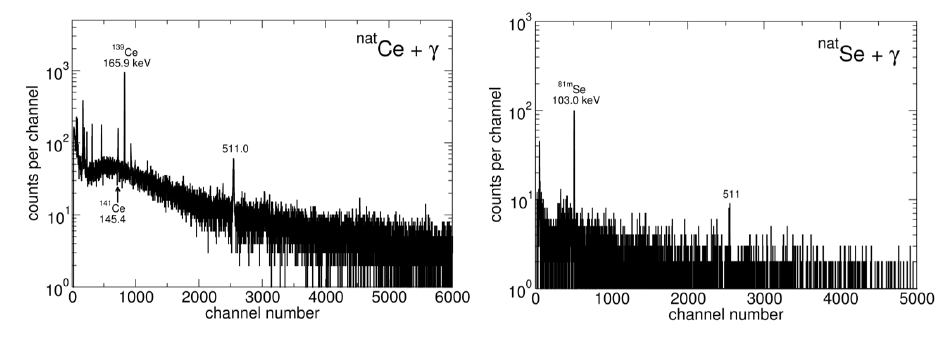
Figure 4: Gamma spectra accumulated with a shielded High-Purity Ge detector for targets of nat Ce (left) and nat Se (right) activated below the neutron production threshold resulting in only gammas and no neutrons. The 139 , 141 Ce and 81 m Se counts are then subtracted to obtain only the ( n , γ ) cross sections.